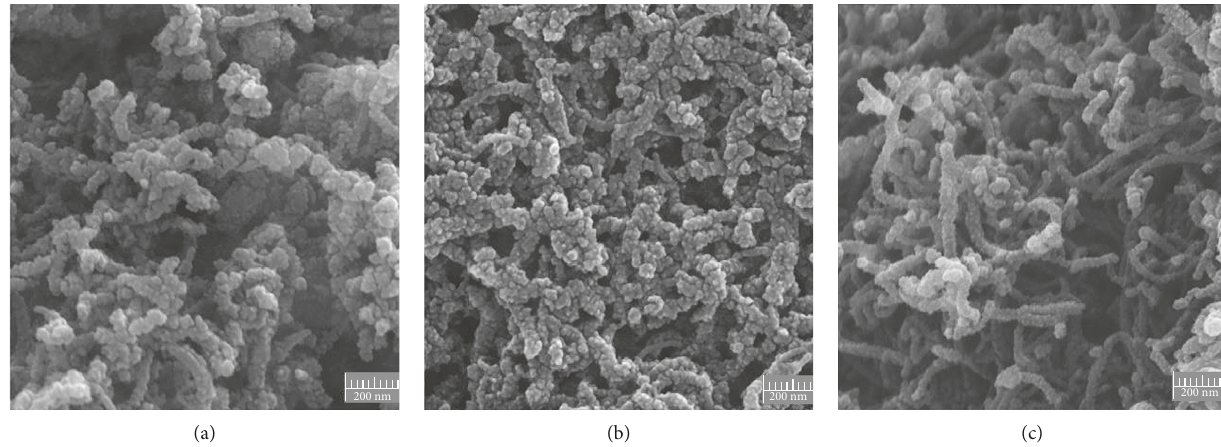
Figure 2: FEG-SEM images of core/shell structures of TiO 2 -coated MWCNT nanocomposites, obtained from different MWCNT con- centrations in water during the sol-gel process: (a) 4mg/mL, (b) 6mg/mL, and (c)